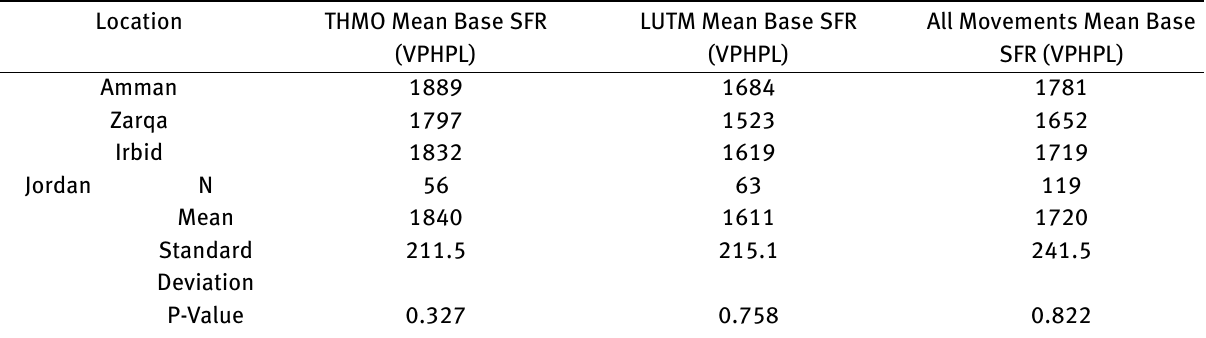
Table 2: Summary of Base SFR Results